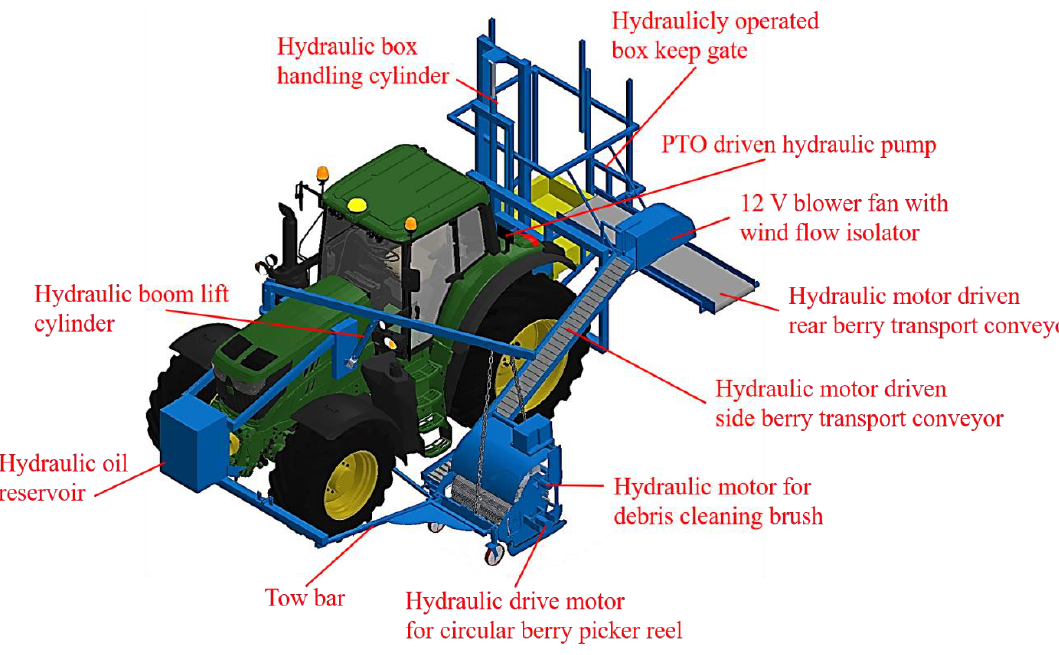
Figure 1. Schematic of Doug Bragg Enterprises (DBE) single-head, wild blueberry harvester with semi automated bin handling system.